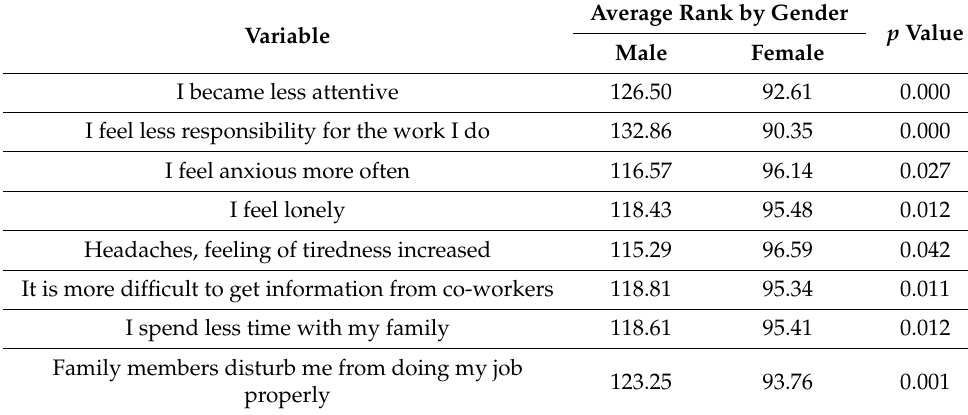
Table 5. The effect of teleworking by